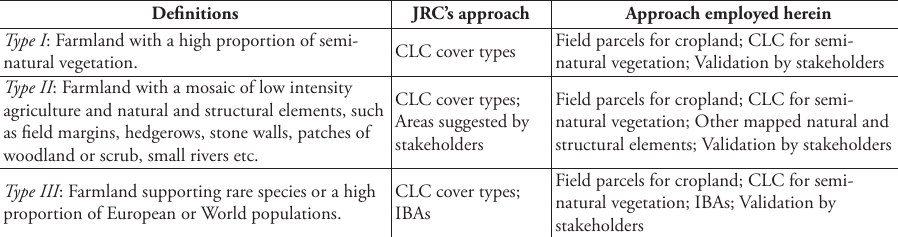
Table 1. HNVf definitions and mapping: A comparison between JRC’s approach (Paracchini et al. 2008) and this